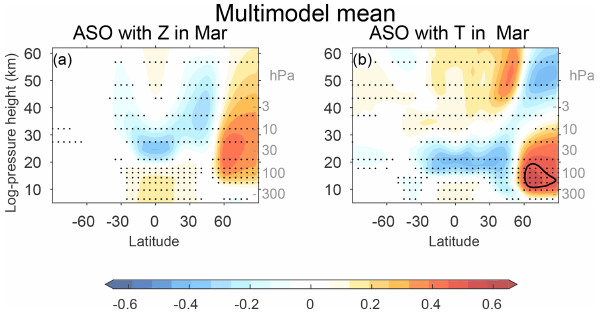
Figure 3. As in Fig. 2 but for the multimodel